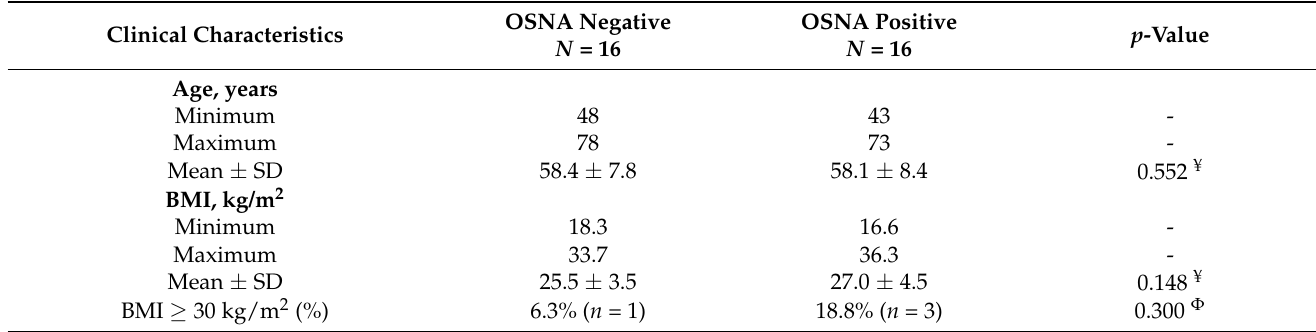
Table 1. Clinical characteristics of the study group, comparing patients with OSNA negative SLNs (pN0) and patients with OSNA positive SLNs (pN1 and pN1mi). Clinical